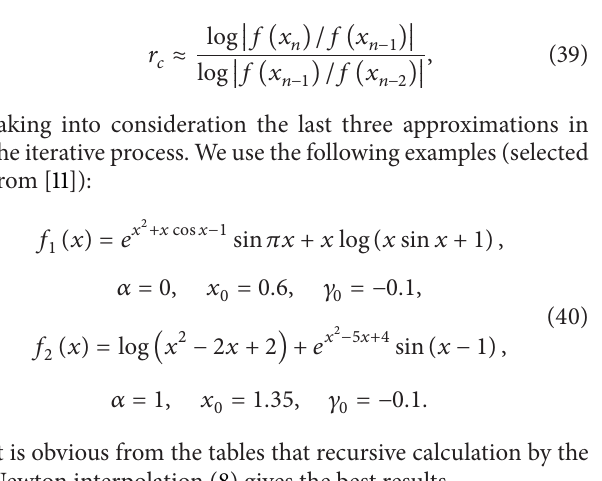
Table 2: Families of three-point methods with memory, for exam- ple, 𝑓 2 (𝑥) .